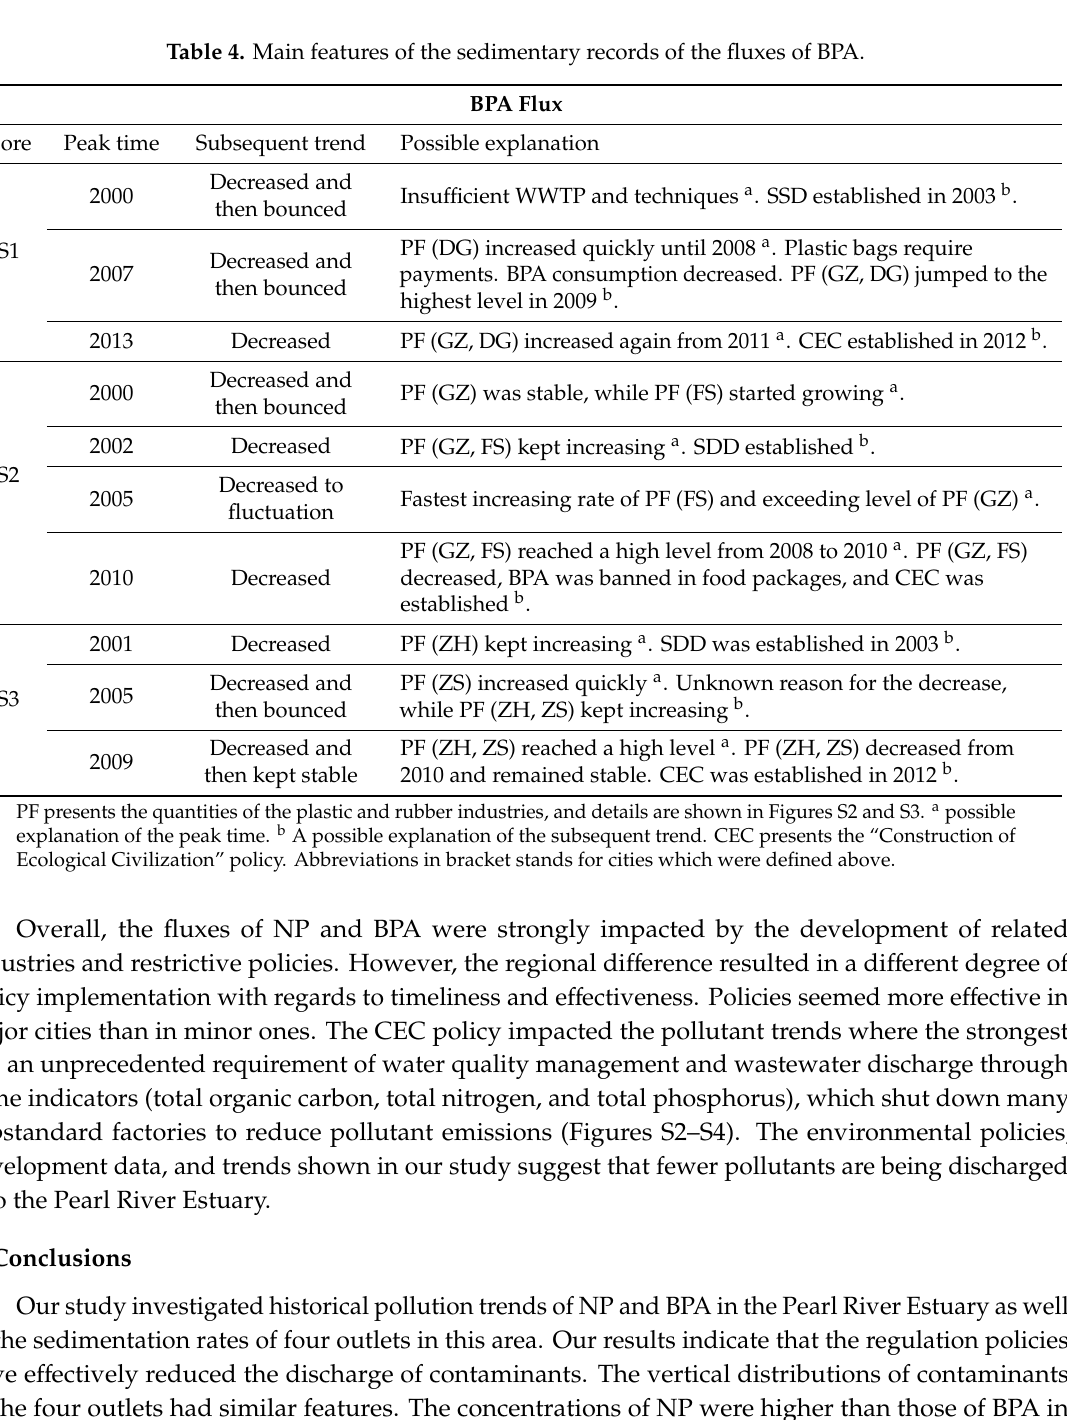
Figure S1: Proportions of light industry (a), heavy industry (b) and plastic and rubber industry (c) among six cities, Figure S2. Trends of light industry enterprise quantity among six cities, Figure S3. Trends of heavy